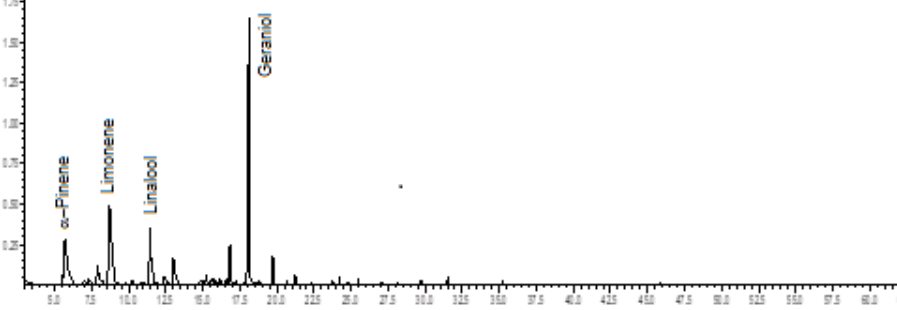
Figure 2. Ion-chromatogram of the Catasetum alatum volatile